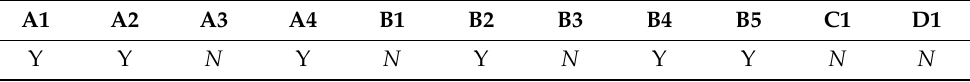
Table 6. Analysis result of meeting the requirements of the platform proposed by Truong et